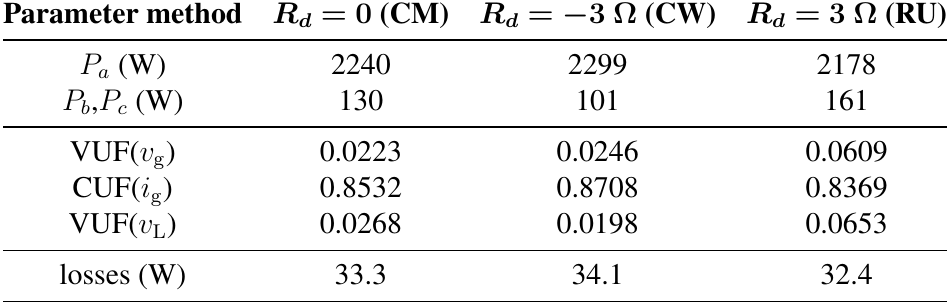
Table 4. One DG unit: CM(Conventional Method) versus RU versus the CW variant = 0 . 3 Ω and R = 1 . 5 Ω ( R l v